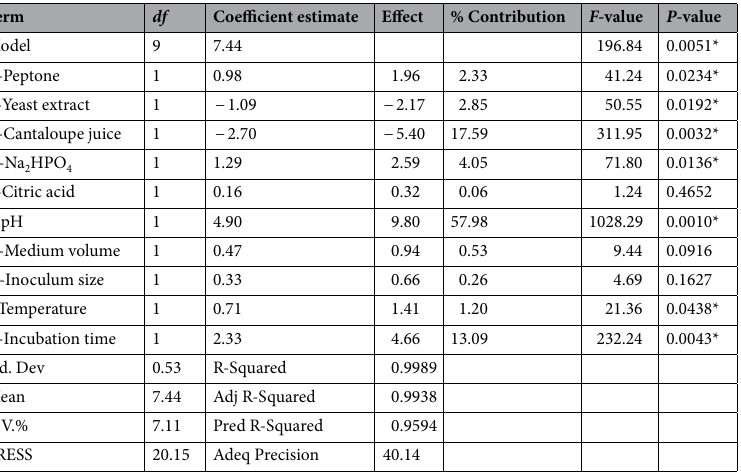
Table 1. Statistical analysis of Plackett–Burman design showing coefficient estimate, effect, % contribution, F -value and P -value for each factor affecting BNC production. * Significant values, F Fishers’s function; P Level of significance; C.V Coefficient of